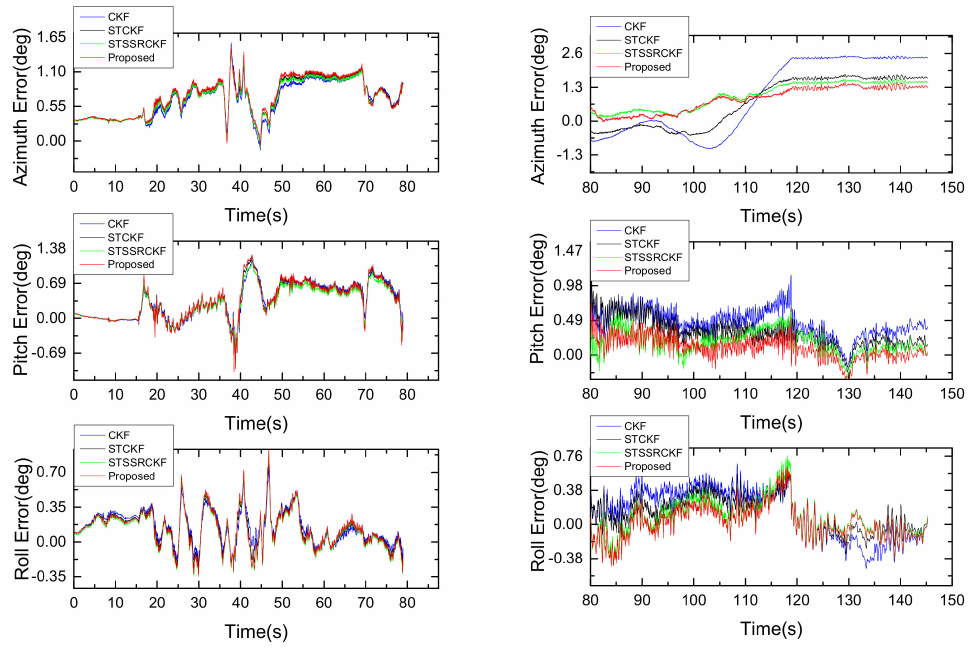
Figure 7. The attitude error in smooth stage ( left ) and maneuvering stage ( right ) from different